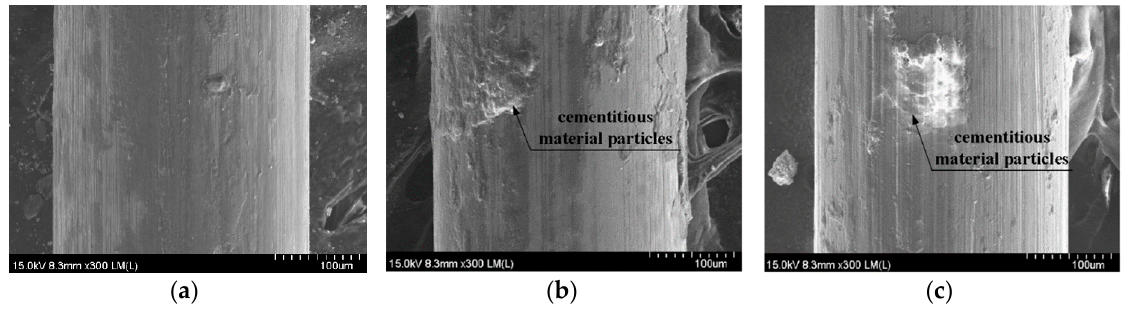
Figure 13. Field-emission scanning electron microscopy (FE-SEM) images of steel fiber surfaces after pullout: ( a ) M0.00, ( b ) M0.05, and ( c ) M0.10.